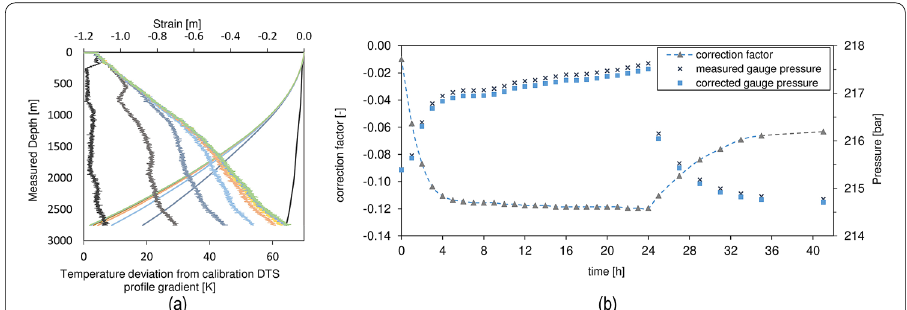
Fig. 13 Calculated strain from DTS and corrected pressure data. a Calculated strain from DTS data to the depth of the P / T gauge in the first 7 h of injection of Inj2. Curves on the left y-axis are temperature deviations from the initial DTS profile. Curves on the right y-axis are the resulting strain for each DTS profile. b Measured gauge pressure data with correction factor to revise thermal caused